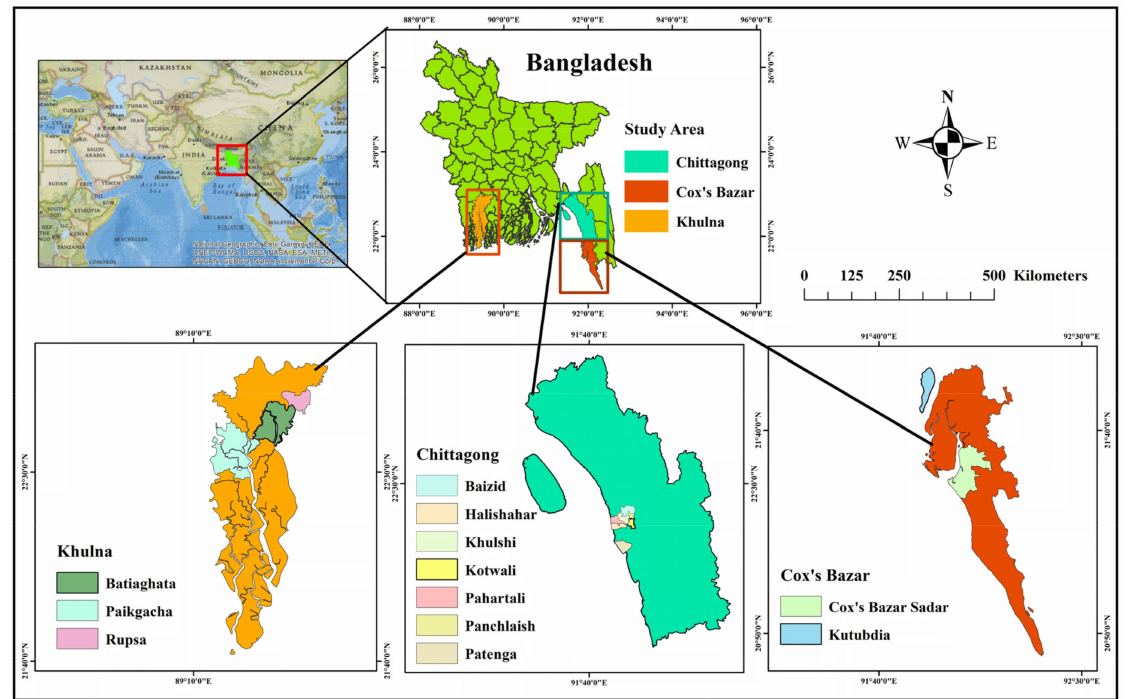
Figure 1. Location of the study